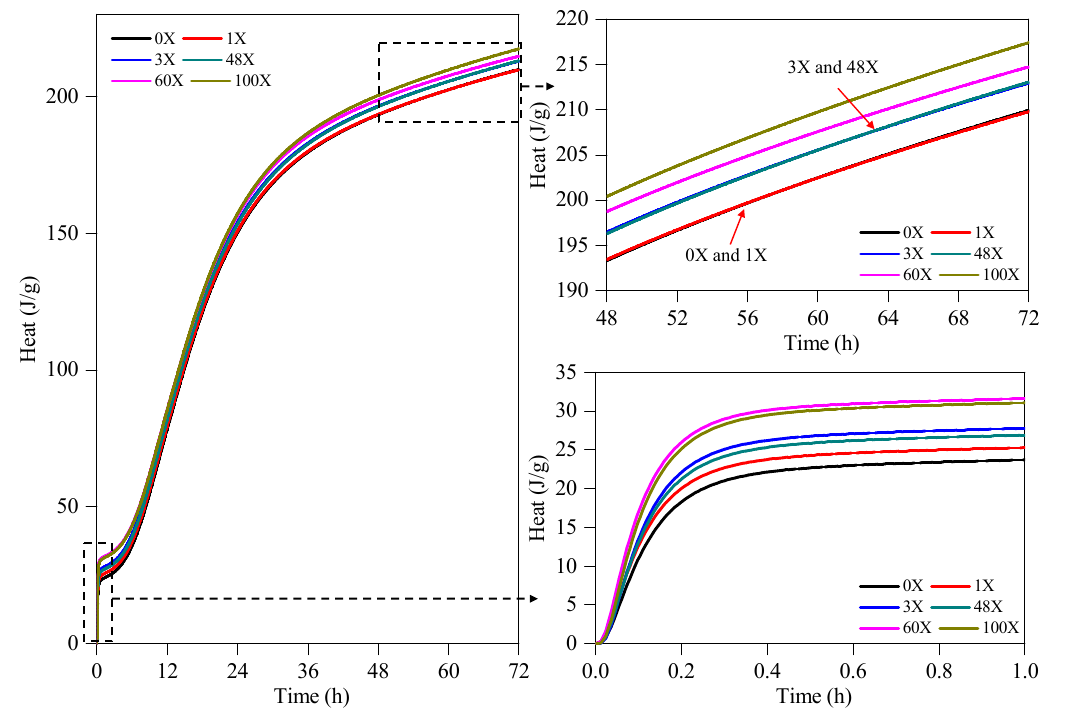
Figure 9. Hydration heat release process from 0 to 72 h with different content of the CTF. (3)